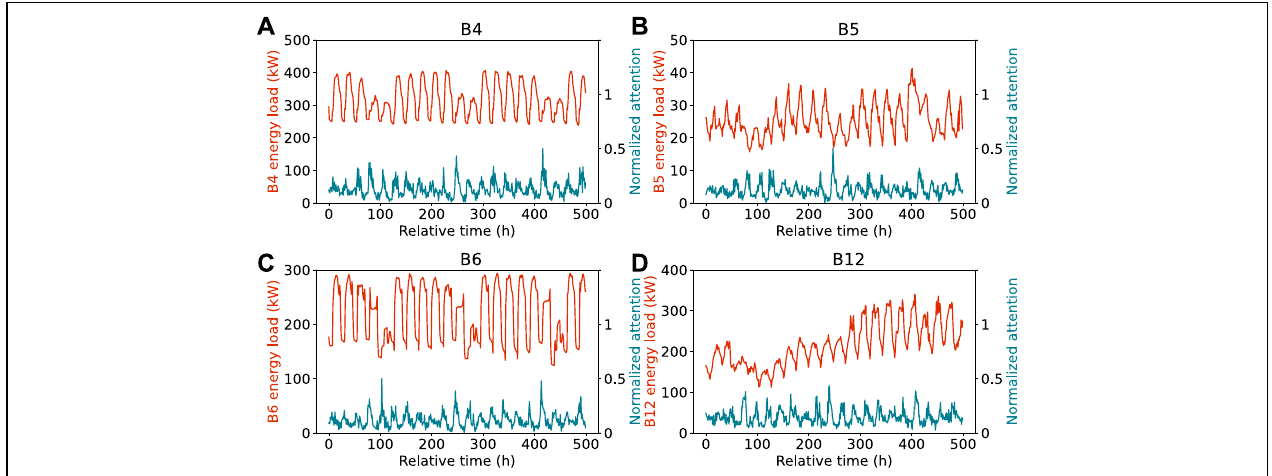
FIGURE 8 | Load and normalized attention to building (A) B4, (B) B5, (C) B6, and (D) B12 for 500 h since 13 September